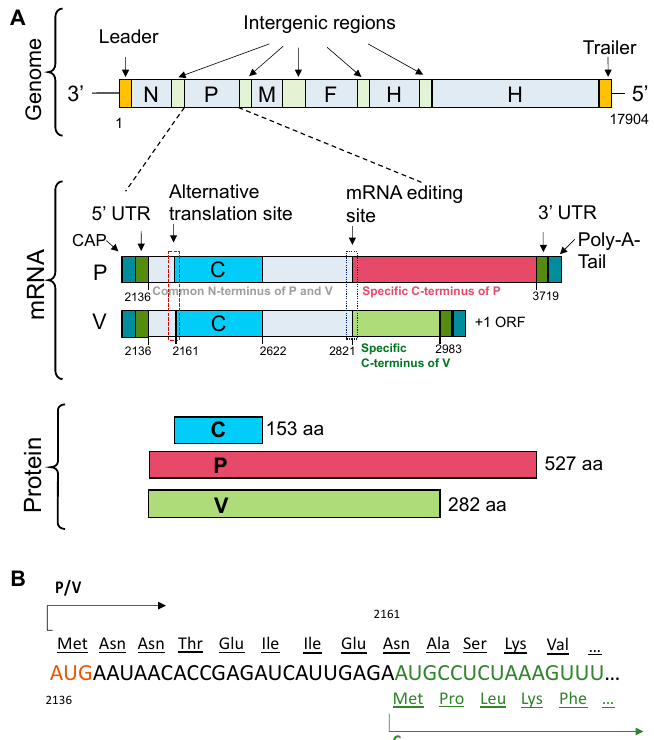
Figure 1. Architecture of the Tupaia paramyxovirus (TupV) genome and expression mechanisms of its P, V, and C proteins. ( A ) The upper panel shows a schematic representation of TupV genome, containing from the 3’ end to the 5’ end, the genes coding for the N, P, M, F, H, and L proteins. The middle panel shows the architecture of the mRNAs generated from the P gene by editing at the nucleotide 2821. The mRNA coding for the P protein is unedited, whereas that coding for the V protein has one G inserted at the editing site. Both mRNA contain the 3’ and 5’ UTR and are processed at both extremities with a CAP structure at the 3’ end and a polyA tail at the 5’ end. The lower panel shows the proteins expressed from these mRNAs. The P and V proteins are expressed by translation initiation at the first AUG codon of their respective mRNA, whereas the C protein is expressed by alternative translation initiation at the next downstream AUG codon from both mRNAs. ( B ) Excerpt of the mRNA coding sequence (of both P and V mRNAs) showing the first AUG initiation codon used for the translation of P or V proteins and the second AUG codon, located in the +1 frame, used for the translation for the C protein.